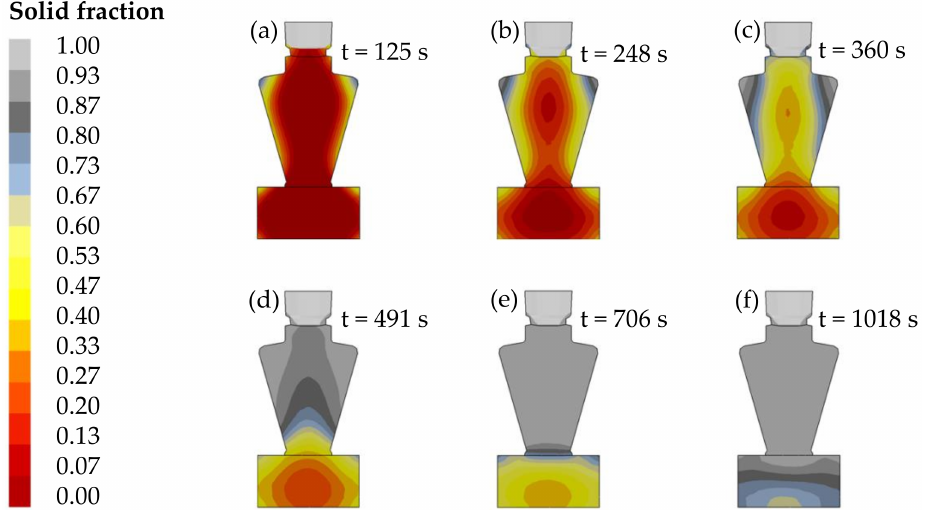
Figure 21. Solidification process of the casted part (cross section view). ( a ) 125 s; ( b ) 248 s; ( c ) 360 s; ( d ) 491 s; ( e ) 706 s; ( f ) 1018